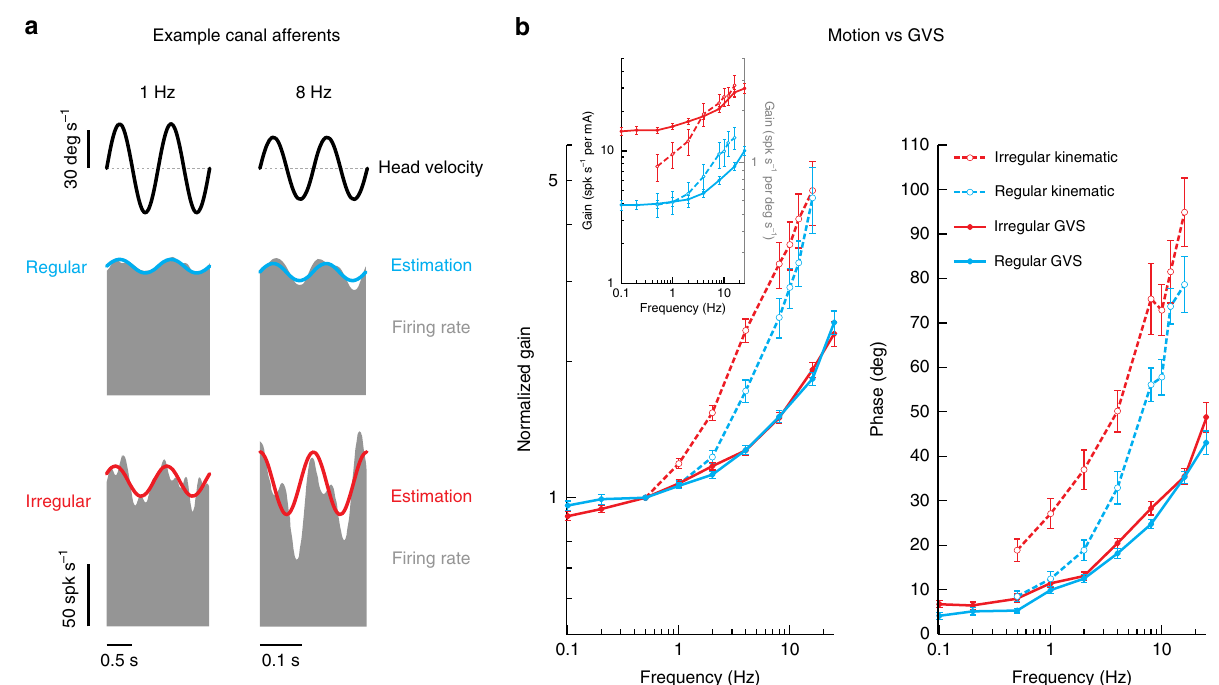
Fig. 4 Comparison of motion and GVS for canal afferents. a Firing rate (gray) of example regular (blue) and irregular (red) canal afferents to 1 Hz (left) and 8 Hz (right) head rotational velocity. Firing rate estimates (solid blue and red line) were found using Eq. 4. The irregular canal afferent was more sensitive to rotation than the regular canal afferent (1 Hz: 1.05 versus 0.60 spk s − 1 per deg s − 1 ; 8 Hz: 2.20 versus 1.05 spk s − 1 per deg s − 1 ). b Population-averaged neuronal gain (i.e., sensitivity) (left) and phase (right) for regular (blue) and irregular (red) canal afferents as a function of the rotation (dashed lines) and GVS (solid lines) stimulus frequency. Gain in the main plot was normalized to responses at 0.5 Hz for comparison of responses across stimulus type, while the inset shows the non-normalized gain plotted with stimulus speci fi c units. Error bars depict the